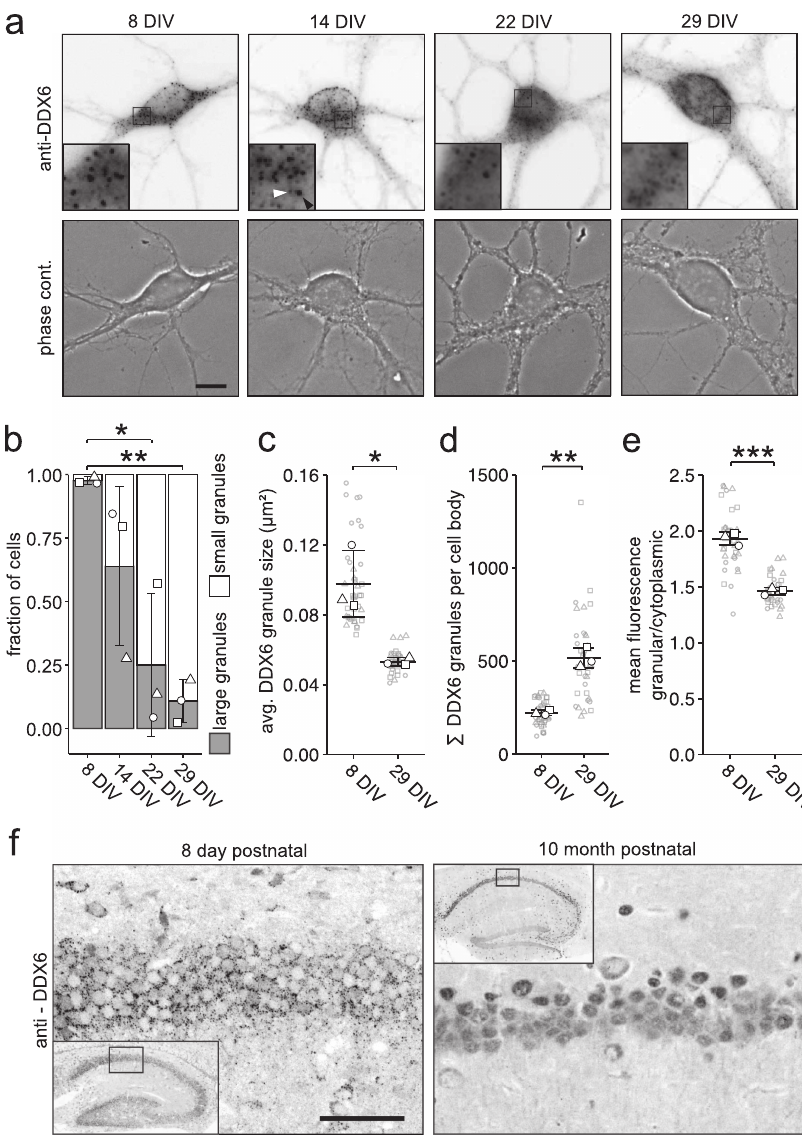
Fig. 1 Cytoplasmic DDX6 granules disassemble during neuronal maturation in cell culture and in vivo. a Representative examples of DDX6 immunostaining and phase contrast of 8, 14, 22, and 29 days in vitro (DIV) hippocampal neurons in culture. Boxed regions in images are displayed as magni fi ed insets. White arrowhead indicates representative small granule, black arrowhead indicates representative large granule. Scale bar 10 µ m. b Bar plot displaying quanti fi cation of cell population by fraction of cells containing either large or small DDX6 granules as exempli fi ed in a , at 8, 14, 22 and 29 DIV, respectively. Data represents mean ± standard deviation of three independent neuronal cultures. Distinct dot symbols indicate biological replicates. At least 100 cells/condition/experiment were quanti fi ed. Asterisks represent p-values obtained by Tukey ’ s test post-hoc to one-way ANOVA analysis (* p < 0.05, ** p < 0.01). F 3,8 = 0.0044. c , d , e Dot plots displaying average DDX6 granule size ( c ), total DDX6 granule number ( d ) and granular to cytoplasmic DDX6 fl uorescence ratio ( e ) of individual cell bodies in 8 and 29 DIV hippocampal neurons in culture. Small gray symbols represent single cells while larger white symbols indicate the average of each replicate. Horizontal line and error bars represent mean of replicates and standard deviation ( n = 3 biologically independent experiments). Asterisks represent p -values obtained by two-sided Student ’ s t -test (* p < 0.05, ** p < 0.01, *** p < 0.001). p = 0.0452 ( c ); p = 0.0081 ( d ). f DDX6 immunostaining on sagittal brain tissue slices displaying the hippocampus of 8 day and 10 month postnatal mice. Boxed regions in overviews show location of magni fi ed region. Scale bar 50 μ m. This experiment was repeated independently 3 times with similar p = 0.00053, Fig. 2d; p = 0.00010). Importantly, these newly